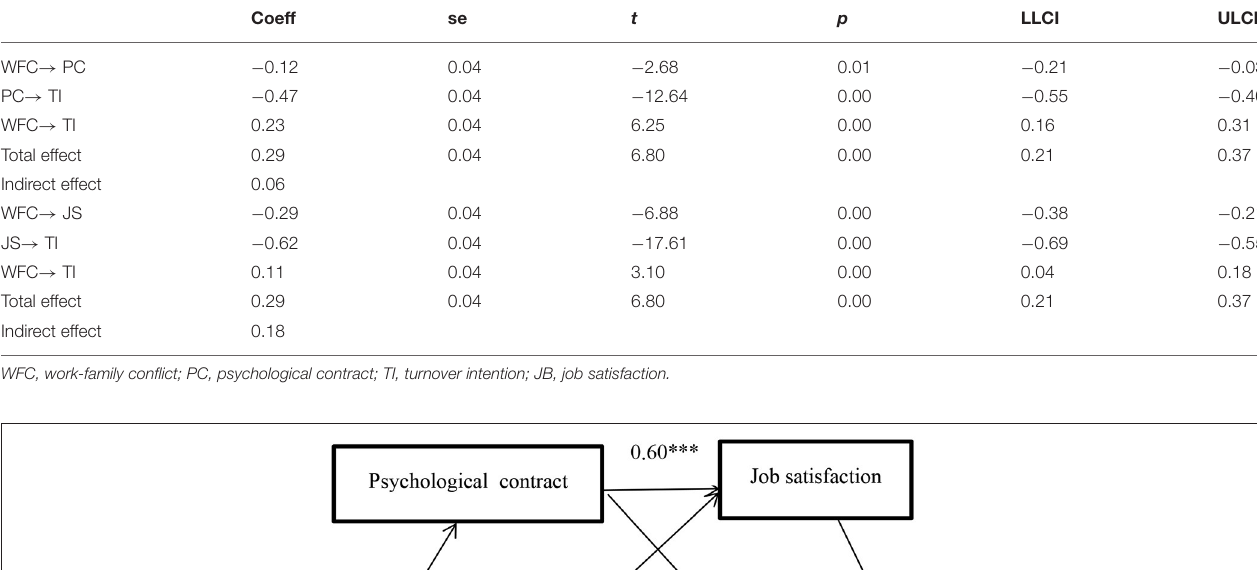
TABLE 4 | Mediating effect test.